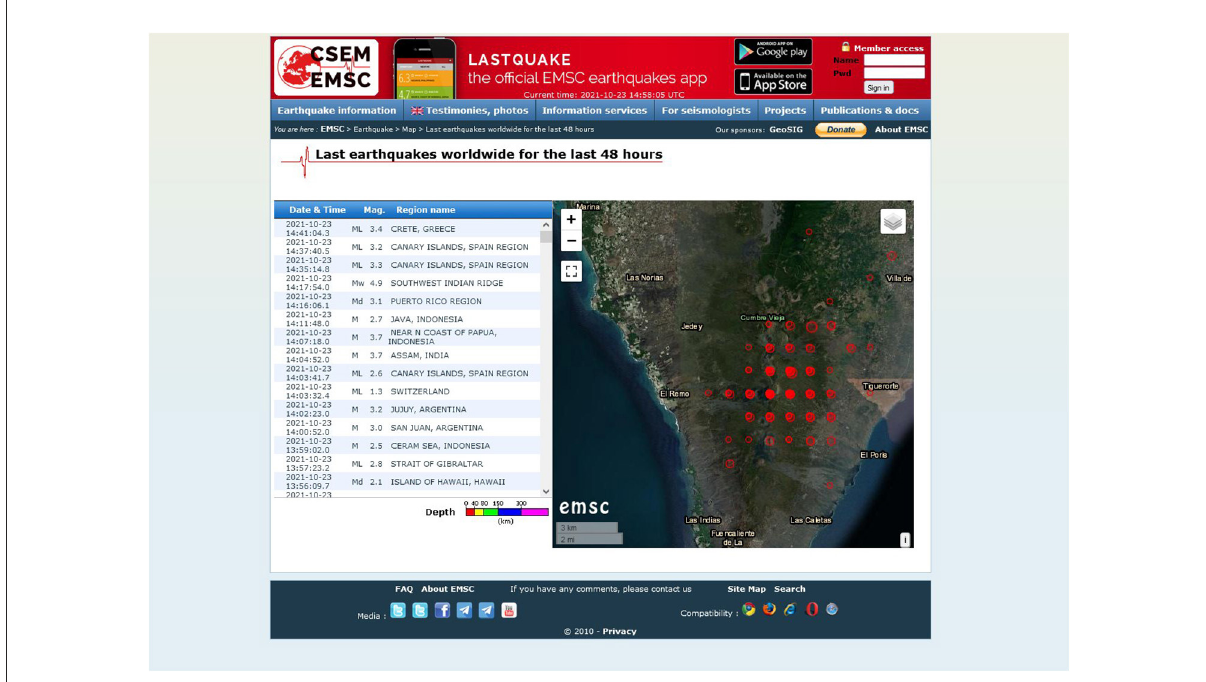
FIGURE1 Screenshot of the EMSC website displaying the earthquake map with the grid pattern (Screenshot 17 June 2022).